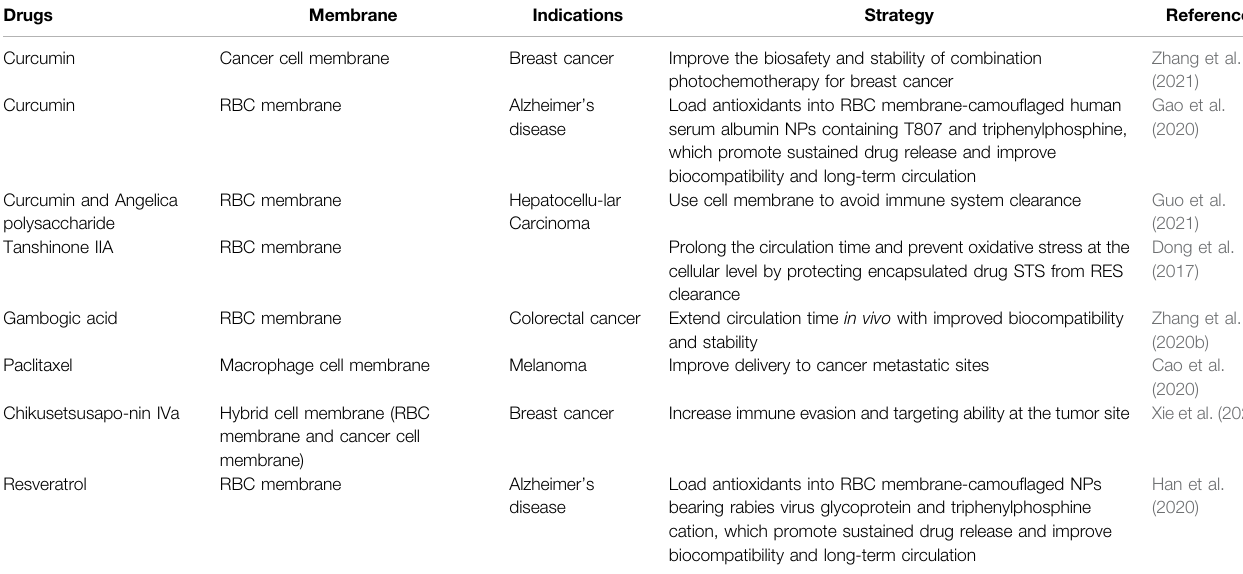
TABLE 2 | Summary of Chinese medicine ingredients used in cell membrane coating research.